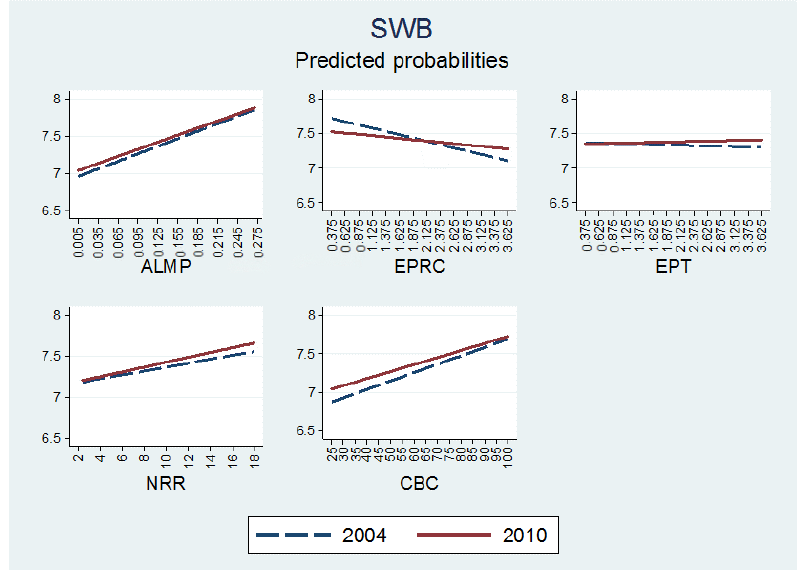
Figure 5. Institutions, SWB, and the crisis. Source: Pooled data from the second and fifth waves of the European Social Survey. Notes: (1) For EPRC and EPT, the sample includes only temporary workers. (2) Predicted probabilities were plotted with the full set of controls. All control variables are set to their mean. (3) Likelihood ratio tests (Prob > F) for whether the interaction effect is statistically significant: ALMP = 0.48; EPRC = 0.00; EPT = 0.30; NRR = 0.27; CBC = 0.01. Confidence intervals are available upon request.